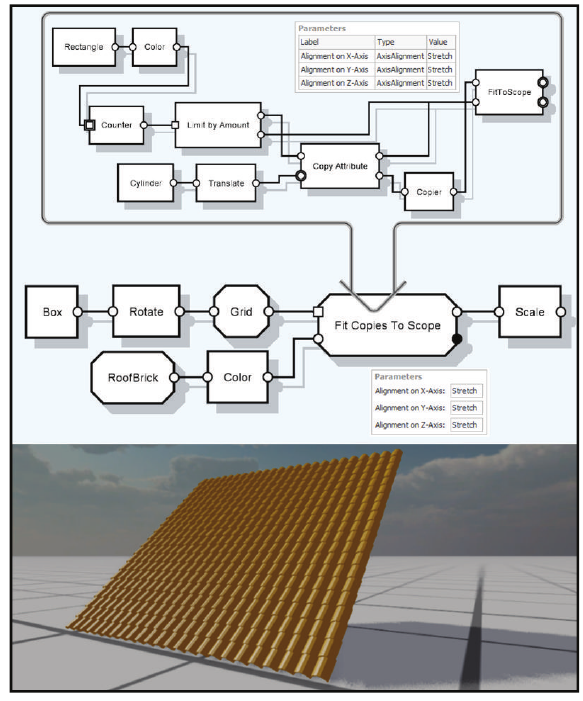
Figure 5: Encapsulation of a graph that extends the “fit-to-scope” operation to lists. Thethick-line portsindicate thegates of thegraph, which are mapped to the encapsulated node’s ports. Graph param- eters are also mapped to the node’s parameters. The supergraph uses this encapsulated graph to easily copy and fit a brick rooftop into each cell of a rectangular grid (both brick and grid are also encapsulations). The result is a detailed roof